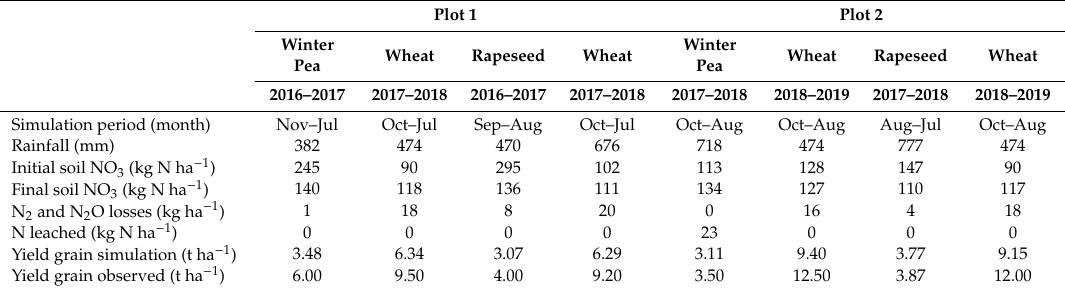
Table 3. STICS simulation of databases of the two plots for each crop. Plot 1 Plot 2 Winter Wheat Rapeseed Pea